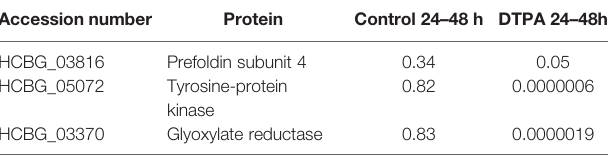
TABLE 2 | Core proteins identi fi ed regulated by zinc and